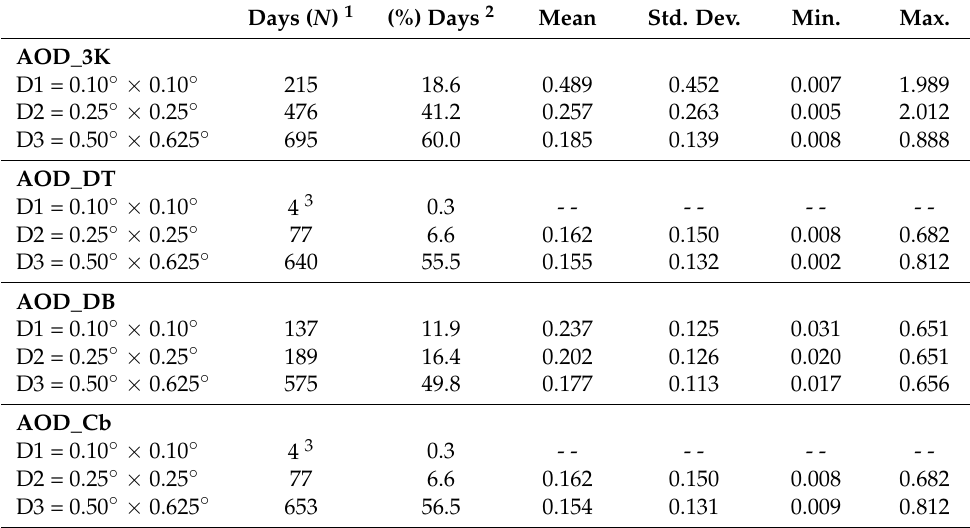
Table 2. Descriptive statistics of the four AOD-SDSs averaged in the three tested domains (D1, D2, and D3 as per Figure 1). Days ( N ) 1 (%) Days